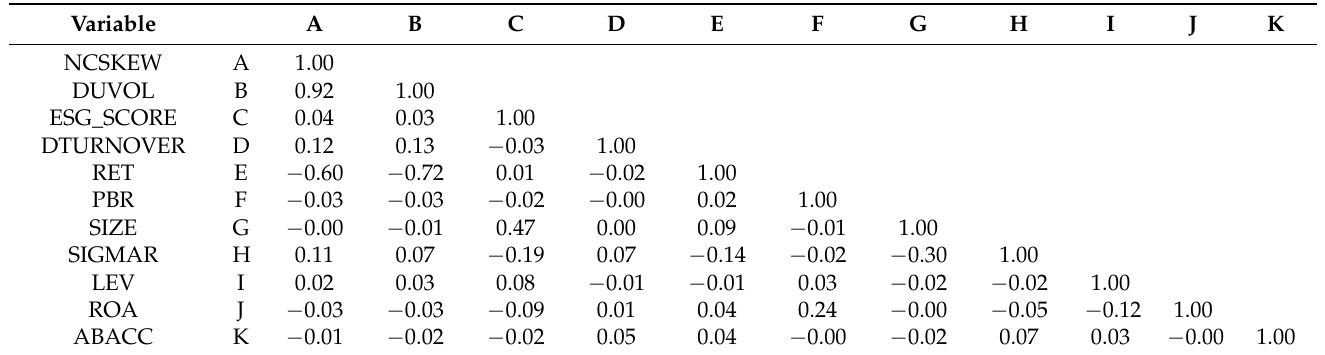
Table A1. Correlation matrix for Euro STOXX 600